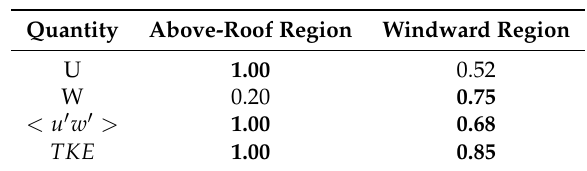
Table 8. Hit rate metric q